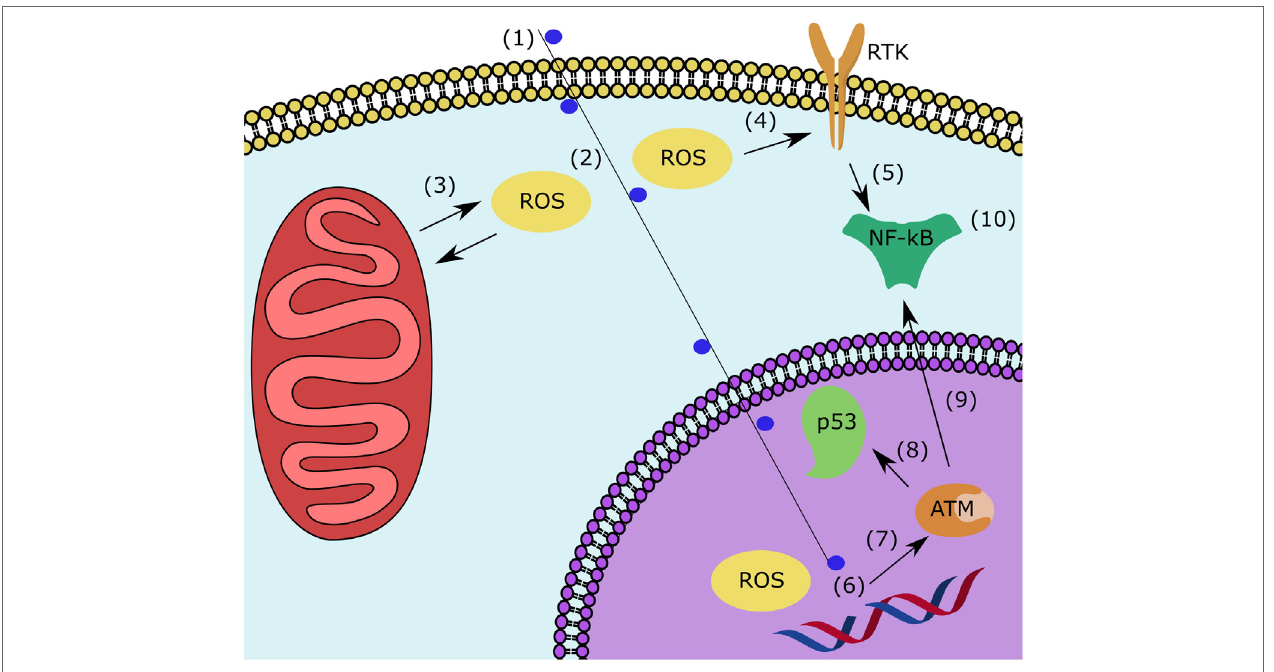
FiGURe 3 | After sublethal irradiation, multiple events in the nucleus and cytoplasm contribute to the inflammatory state responsible for RICVD. In the cytoplasm, (1) sublethal irradiation of an off-target cell leads to (2) ROS formation and (3) ROS-induced-ROS release from the mitochondria. (4) ROS lead to ligand-independent activation of RTK which leads to expression of many pathways that (5) induce NF- κ B. In the nucleus, (1) sublethal ionizing radiation leads to (6) ROS formation and single-stranded DNA breaks. (7) In response to DNA damage, ATM and ATM and AT and Rad3-related kinase are activated. (8) They induce p53 activation leading to cell cycle arrest and DNA repair as well as (9) inducing NF- κ B. (10) NF- κ B activation from both pathways induces factors that lead to antiapoptotic, radiation resistance, and inflammatory signaling. The presented mechanism is generally expected to occur in all sublethally irradiated cell types, but the pathogenesis of RICVD is first seen in the endothelial cells. Abbreviations: RICVD, radiation-induced cardiovascular disease; ROS, reactive oxygen species; RTK, receptor tyrosine kinase; NF- κ B, nuclear factor kappa B; ATM, ataxia-telangiectasia mutated